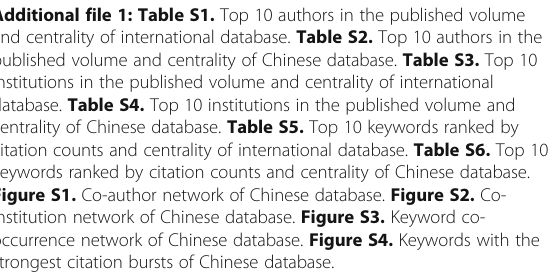
Figure S1. Co-author network of Chinese database. Figure S2. Co- institution network of Chinese database. Figure S3. Keyword co- occurrence network of Chinese database. Figure S4. Keywords with the strongest citation bursts of Chinese